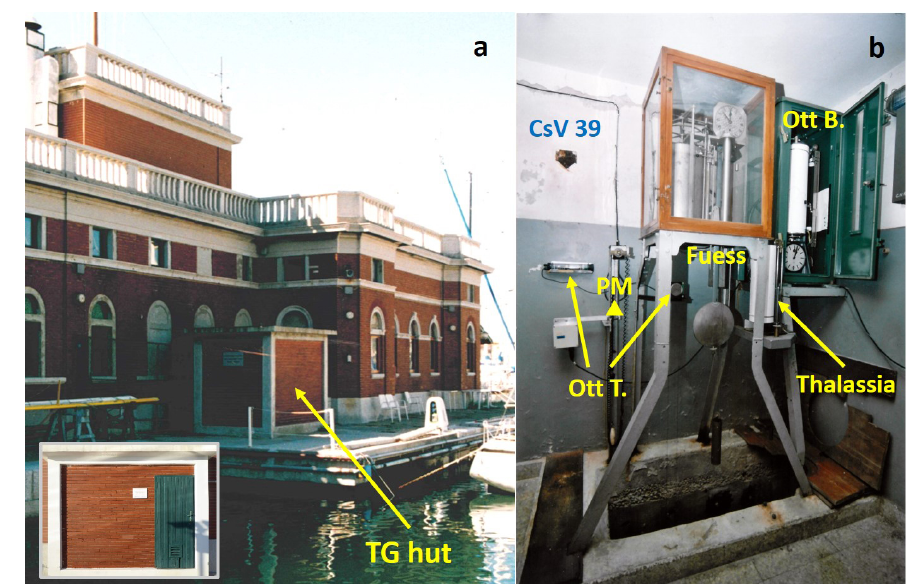
Figure 4. (a) The tide-gauge hut in 2001; since 2004, only the wall indicated by the arrow has been visible (see the inset), because the hut is enclosed in the main building, which was enlarged. (b) The inside of the tide-gauge hut in 2001. Four instruments are shown: Ott Thalimedes (1st) (Ott T.), Ott Büsum (Ott B.), Thalassia, and Fuess. PM is the tide-gauge contact point (TG CP), and CsV 39 is a vertical benchmark no longer present. (Photographs by CNR-ISMAR,